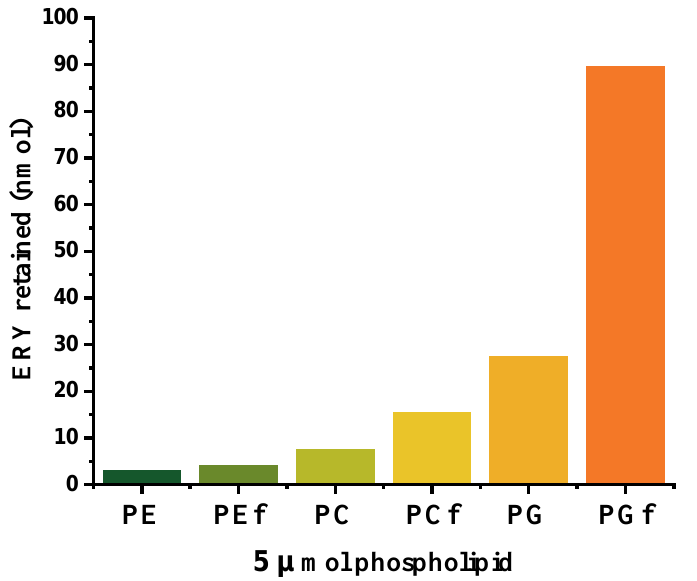
Figure 3. The improvement of ERY loading into liposomes, due to the presence of fatty acids (in the codes, “f” indicates the presence of fatty acids into the phospholipid composition).